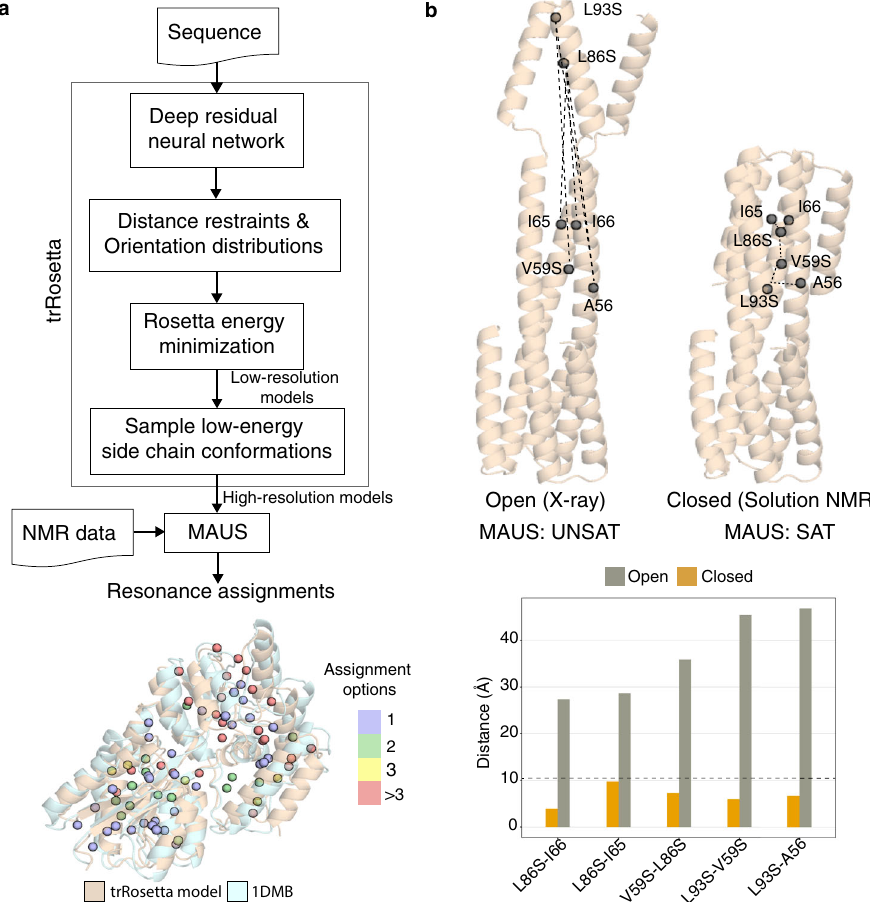
Fig. 5 Robustness of MAUS assignments from different structural models. a Top: fl owchart showing the combined de novo structure modeling and methyl resonance assignment strategy using trRosetta (transform-restrained Rosetta) and MAUS, respectively. (bottom) Overlay of trRosetta model (wheat) and X-ray structure (PDB ID: 1DMB; pale cyan) of maltose-binding protein. Number of resonance assignment options identi fi ed by MAUS are indicated by colored spheres (violet: 1, green: 2, yellow: 3 and red: >3). b Top: structures of a designed homotrimeric protein 27 , in the open (solved by X-ray crystallography) and closed (solved by solution NMR) states showing inter-methyl distances corresponding to experimental NOEs identi fi ed in a 3D C M -C M H M NOESY spectrum, assigned manually 27 . Gray spheres show methyl residues participating in the NOE network. The dashed lines represent pairwise distances in the two models, also shown as bar plots (bottom) for the open (gray) and closed (golden) states. The dashed line in the bar plot highlights the 10 Å NOE upper distance limit used by MAUS. Using the unassigned NOE peaks, MAUS delivers a set of satisfying assignments when provided with a model of the closed, but not of the open structure as proteins were exhaustively buffer exchanged in their respective buffers (see section TEV (Tobacco Etch Virus) protease and the cleaved af fi nity tag, and further “ Stereospeci fi c isotopic labeling ” ). puri fi ed by SEC on a Superdex 200 16/60 column (GE Healthcare) in 20mM Tris pH 7.5, 200 mM KCl, 1 mM TCEP, and 5% (vol/vol) glycerol. Streptococcus pyogenes Cas9 domain constructs . The coding sequences for Cas9 Human IL-2 expression, refolding, and puri fi cation . Codon optimized DNA HNH (residues 776 – 908) and REC2 domains (residues 167 – 307) were synthesized, encoding the human IL-2 (amino acids 1 – 133) with a site-speci fi c mutation codon optimized for expression in E. coli , and subcloned into a His 10 -MBP (C140S) (Supplementary Table 6) was expressed in BL21 (DE3) E. coli cells as expression vector (Genscript) (Supplementary Table 6). pSHS325 bacterial inclusion bodies. Protein expression was achieved by induction with 1mM IPTG at expression plasmid for SpCas9 REC3 domain was a gift from Jennifer Doudna & an OD600 of 0.6 followed by cell growth at 37 °C for 5h at 200 r.p.m. For in vitro Keith Joung (Addgene plasmid #101205) 30 . Each protein was expressed in E. coli refolding, ~30mg of inclusion bodies was dropped diluted into 200 mL of refolding BL21 (DE3) containing chaperone plasmid pG-KJE8 (TAKARA, 3340) to enhance protein folding 31 and puri fi ed as described below 32 . Brie fl y, when cells reached an OD600 of ~0.6, IPTG was added to a fi nal concentration of 0.5mM to induce protein expression. Cells were then grown for an additional 18h at 23°C. Collected cells were resuspended in lysis buffer (50 mM Tris pH 7.5, 500 mM NaCl, 5% (v/v) matography with a CAPTO-SP column using a 25mM to 1M NaCl gradient in a glycerol, and 1mM Tris(2-carboxy-ethyl) phosphine (TCEP) containing an EDTA- buffer with 25mM MES pH 6.0 followed by SEC with a Superdex 75 column (GE) free protease inhibitor tablet (Roche). The cell suspension was sonicated on ice and clari fi ed by centrifugation at 27,000 × g for 15min. The soluble lysate fraction was bound in batch to Ni-NTA agarose (Qiagen). The resin was washed extensively NanoDrop with extinction coef fi cients estimated with the ExPASy ProtParam tool. with 20 mM Tris pH 7.5, 500 mM NaCl, 1mM TCEP, 10 mM imidazole, and 5% (vol/vol) glycerol, and the bound protein was eluted in 20 mM Tris pH 7.5, Preparation of NMR samples, backbone, and methyl assignments . All proteins 500 mM NaCl, 1mM TCEP, 300 mM imidazole, and 5% (vol/vol) glycerol. The His 10 -MBP af fi nity tag was removed with His 10 -tagged TEV protease during were overexpressed in M9 medium in 2 H 2 O containing 2gl − 1 2 H 13 C glucose overnight dialysis against 20 mM Tris pH 7.5, 500 mM NaCl, 1mM TCEP, and 5% (Sigma #552151) and 1g l − 1 15 NH 4 Cl. Selective methyl labeling, referred to as (vol/vol) glycerol. The protein was then fl owed over Ni-NTA agarose to remove ILV * , was achieved by the addition of appropriate precursors (ISOTEC Stable